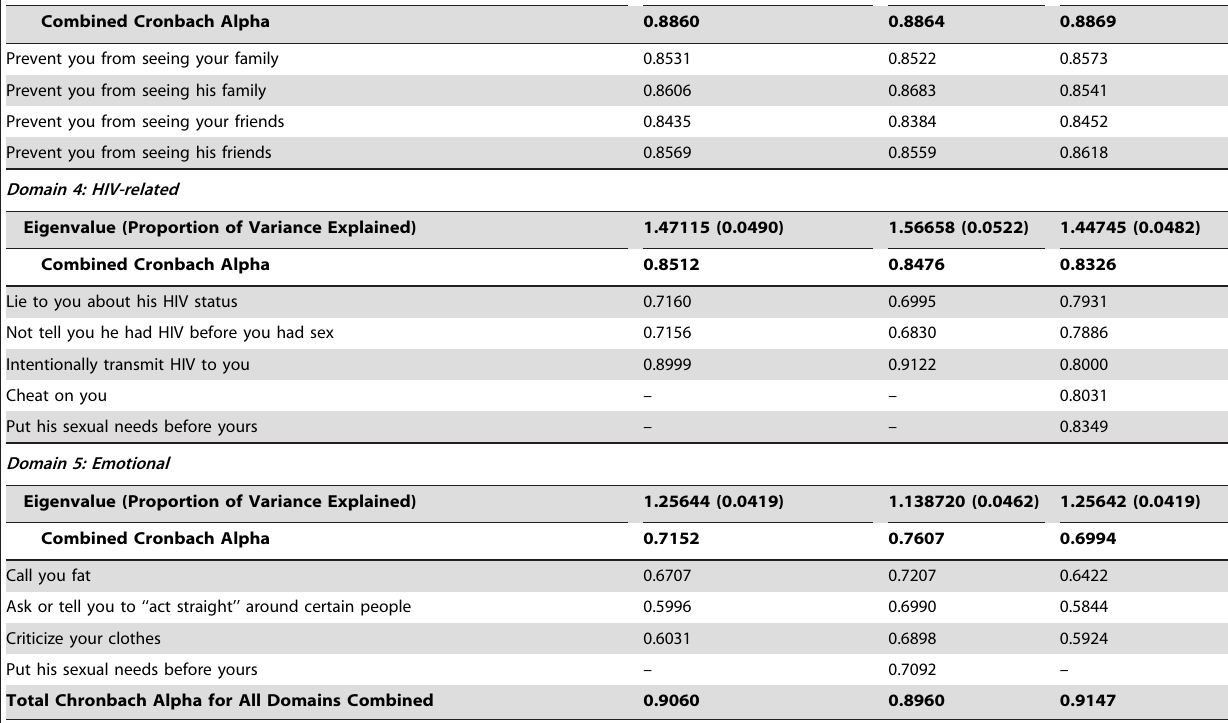
All men White men Black